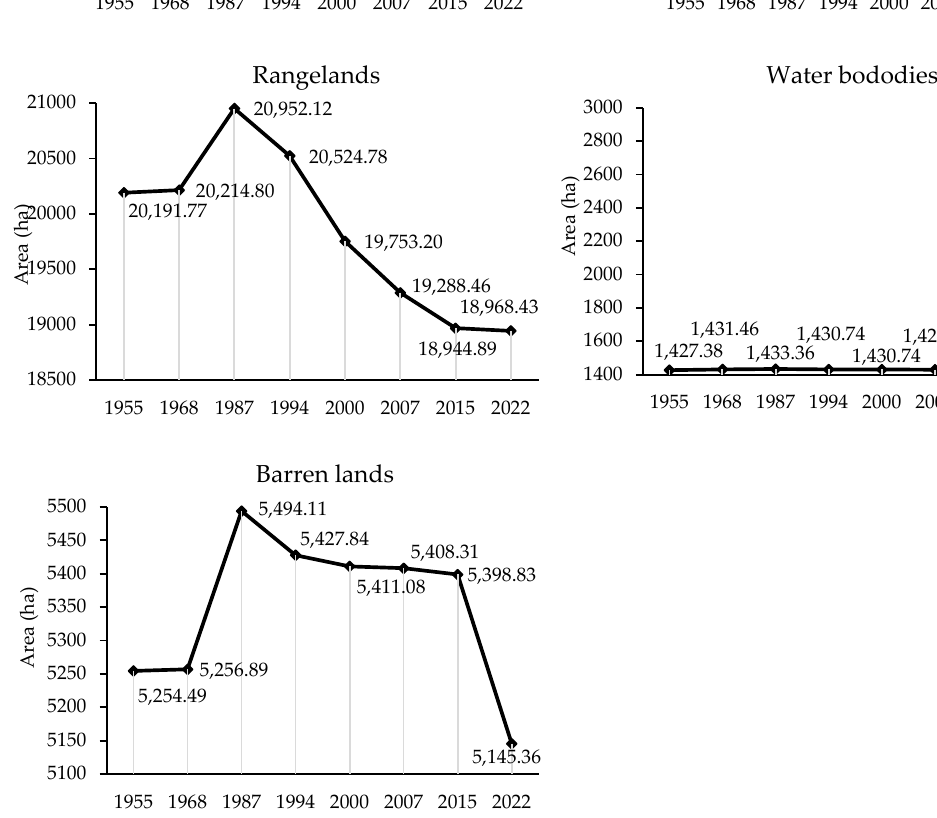
Figure 6. Changes in the area of land use types within the study’s time period.